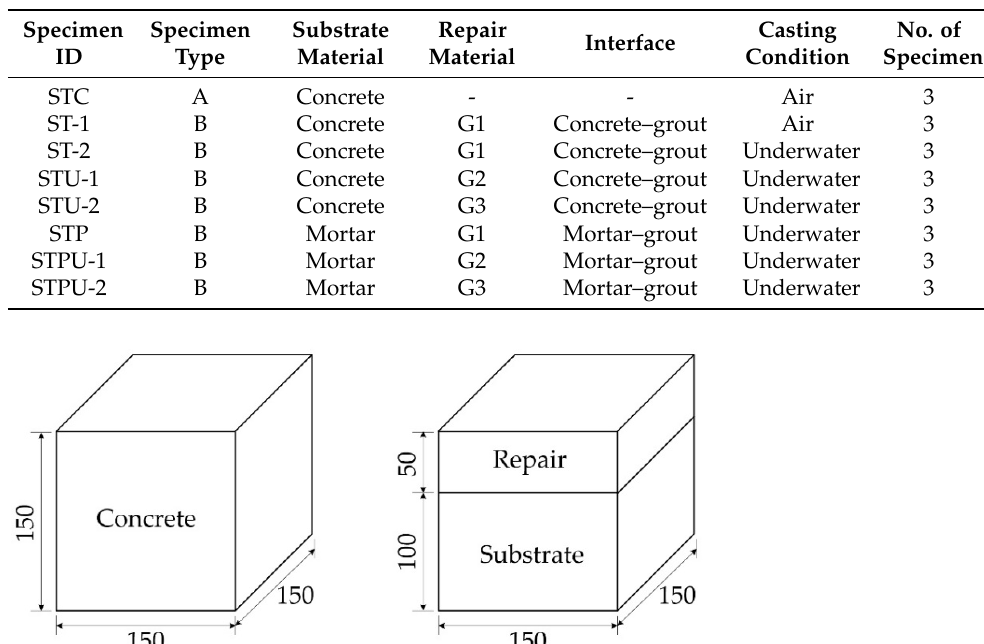
Table 4. Characteristic of bond test specimens.